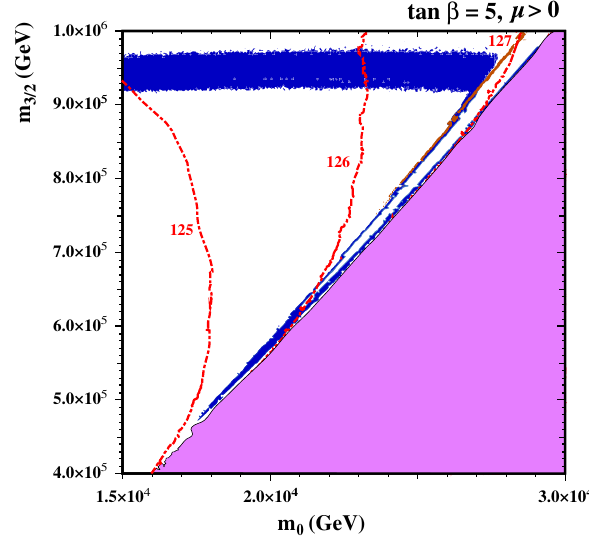
Fig. 3 Blowup of the right panel in Fig. 2. When m 3 / 2 ≤ 9 . 1 × 10 5 GeV, we shade dark blue regions with 0 . 1126 ≤ (cid:4) ˜ χ 0 so as to thicken the slanted V-shaped Higgsino LSP strip. Towards the upper part of the Higgsino strip, there is a thin brown shaded strip that is excluded because the LSP is a chargino. Contours of M h calculated (labelled in GeV) using FeynHiggs 2.11.3 (see text) are shown as red dashed lines